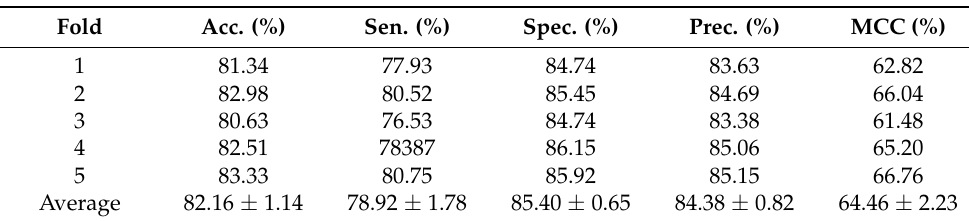
Table 4. The performance of the proposed method in SM2miR datasets.